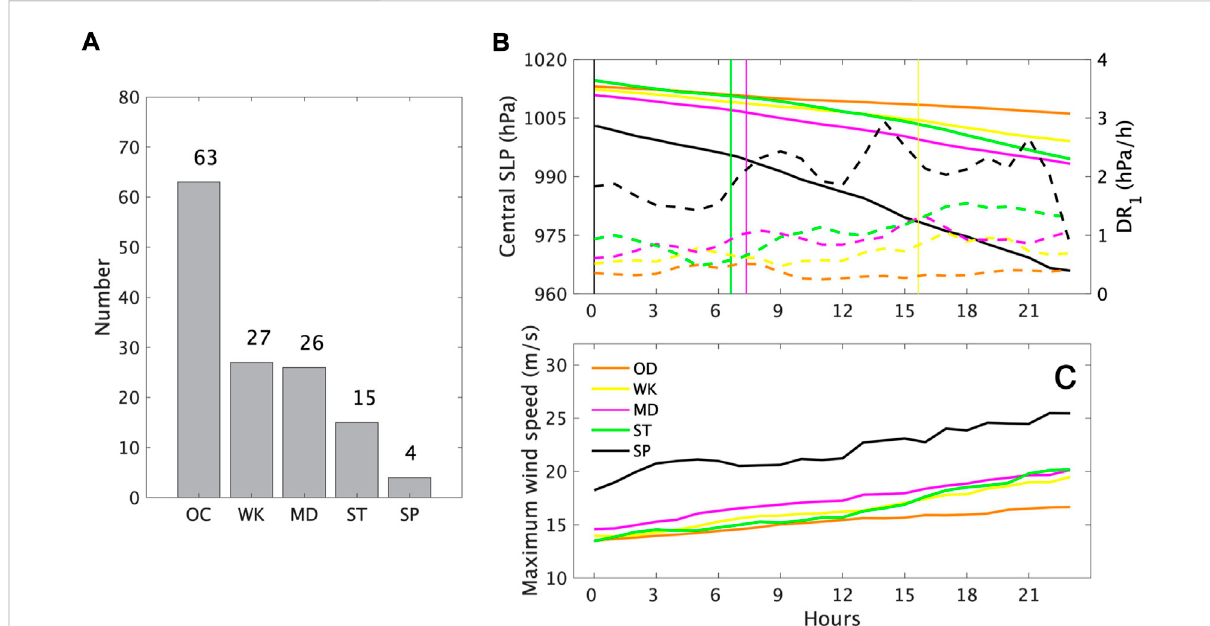
FIGURE 2 Numbers of different categories of cyclones (A) , 24-h variation of their central SLPs (B) , and maximum wind speed (C) . Solid and dashed curves in (B) representthecentralSLPsand1-hdeepeningrate,respectively,andverticallinesshowthebeginningofexplosivegrowth. “ WK, ”“ MD, ”“ ST, ” and “ SP ” denote weak, medium, strong, and super ECs,